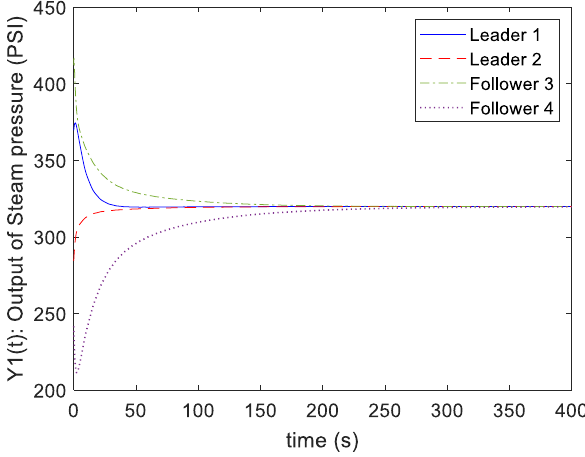
Figure 9. Responses of output Y 1 ( t ) with IT-2 fuzzy control.